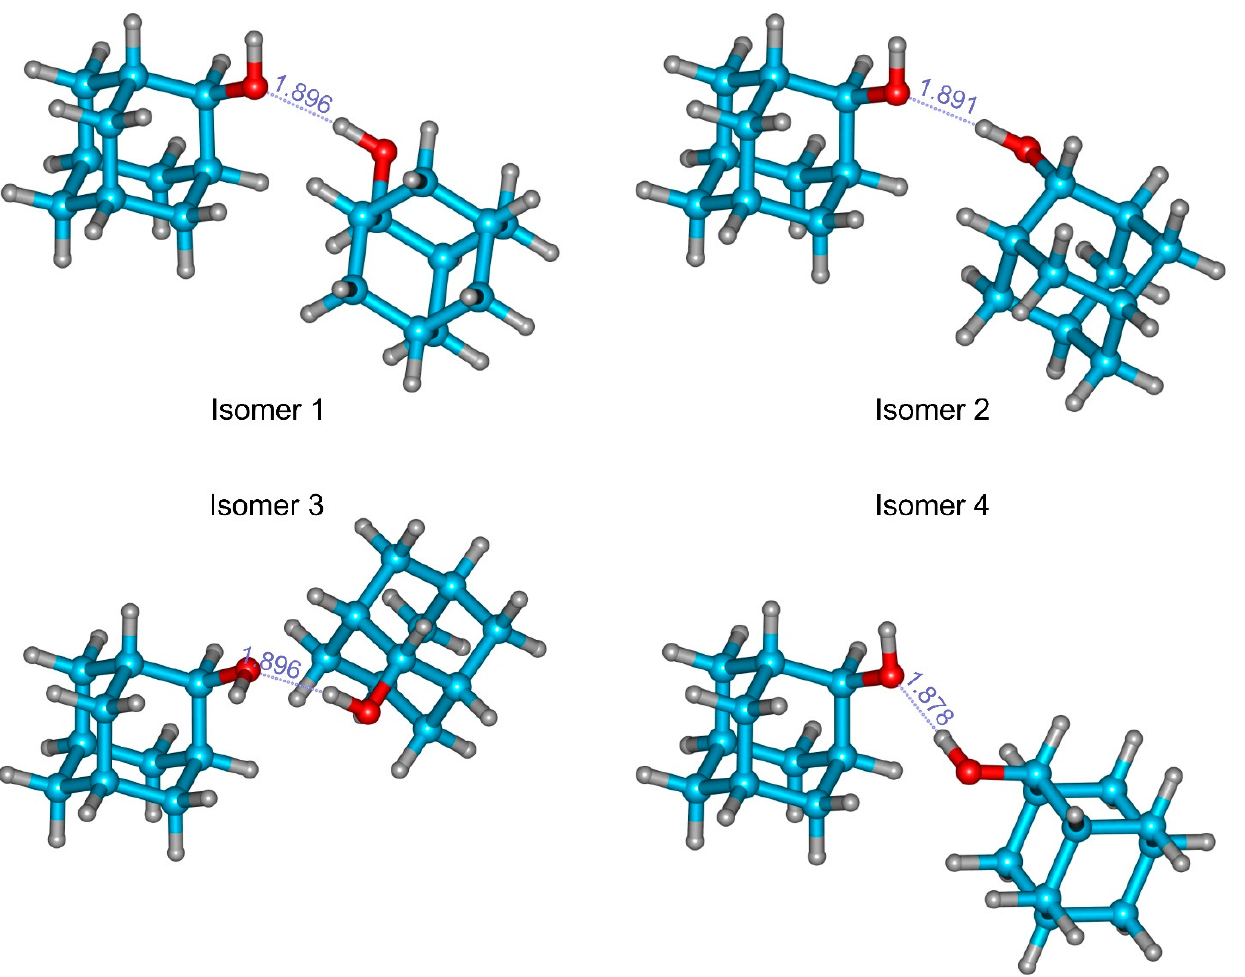
Figure 3. The lowest-lying isomers of the 2-adamantanol dimer are mostly comprised of gauche - gauche isomers. The O-H···O hydrogen bond is represented by a dotted line, together with the bonding distances predicted with B3LYP-D3(BJ)/def2-TZVP.